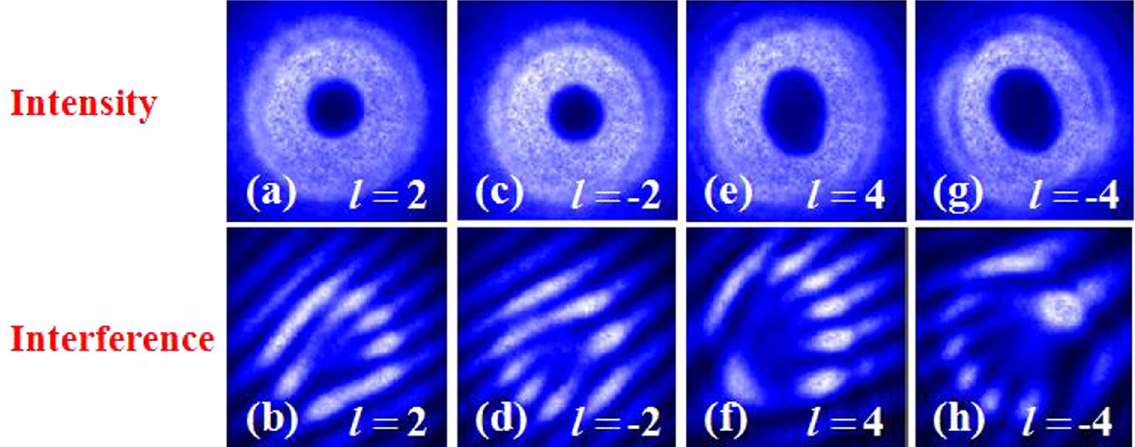
Figure 3. The intensity profiles and interference patterns of VBs obtained by using metasurface. Four different topological charges ( l ), + 2, − 2, + 4 and − 4 are chosed. The first row shows the intensity profiles and the second row shows the interference pattern.